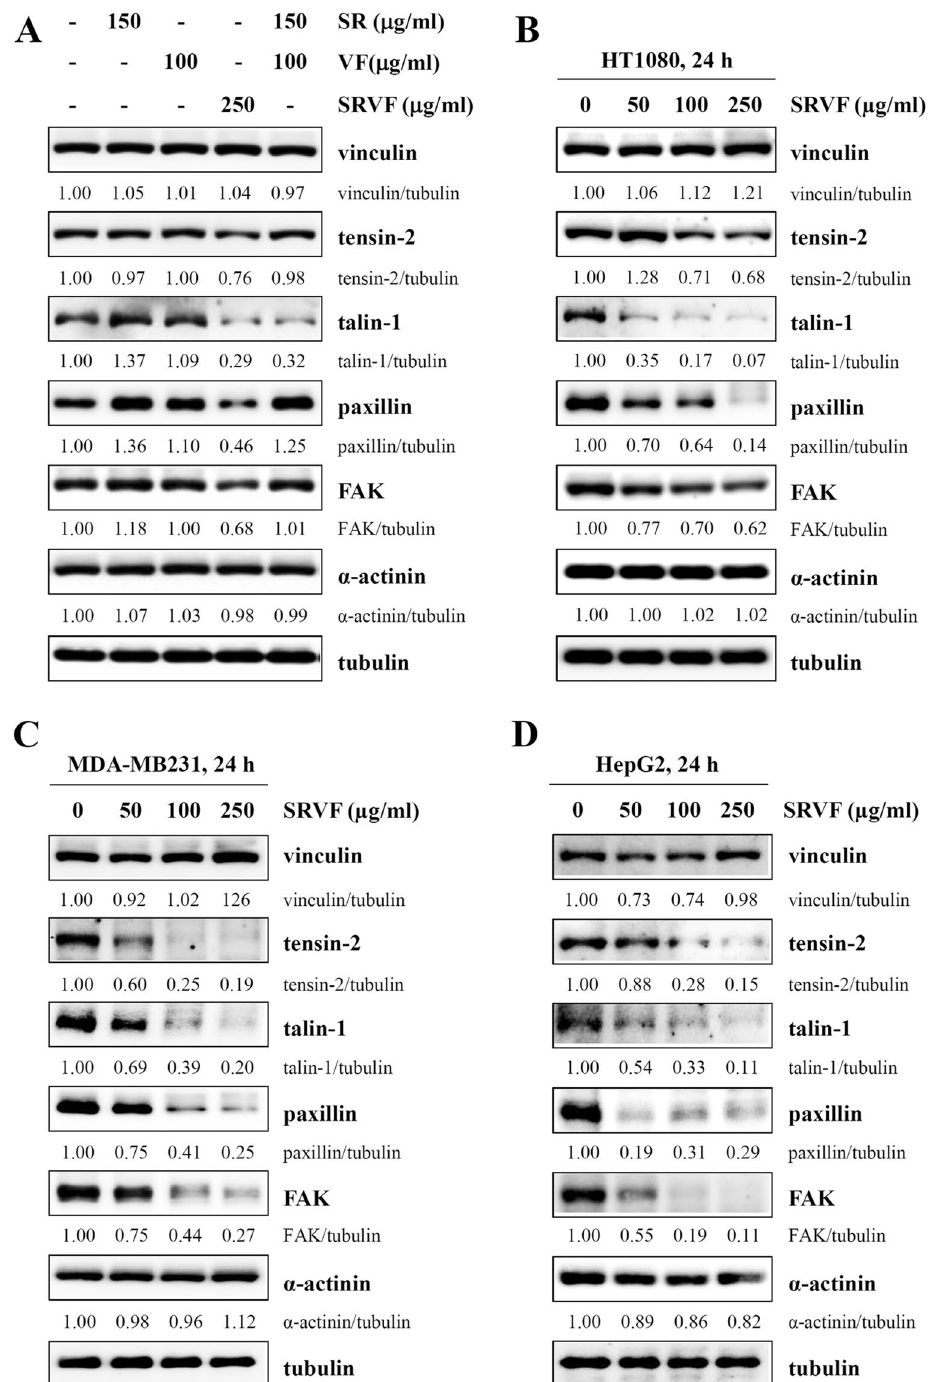
Figure 7. SRVF regulates the expression of focal adhesion-related proteins in cancer cells. ( A ) HT1080 cells were treated with SR, VF, or SRVF for 24 h, and total cell lysates were subjected to Western blotting. ( B–D ) HT1080, MDA-MB231, and HepG2 cells were treated with 50, 100, or 250 µ g/ml SRVF for 24 h, and the levels of focal adhesion-related proteins were determined by Western blotting. Band intensities were calculated using ImageJ software after normalizing to tubulin expression. Data are representative of two independent experiments. The full size blot is shown in Supplementary Figs S7 and